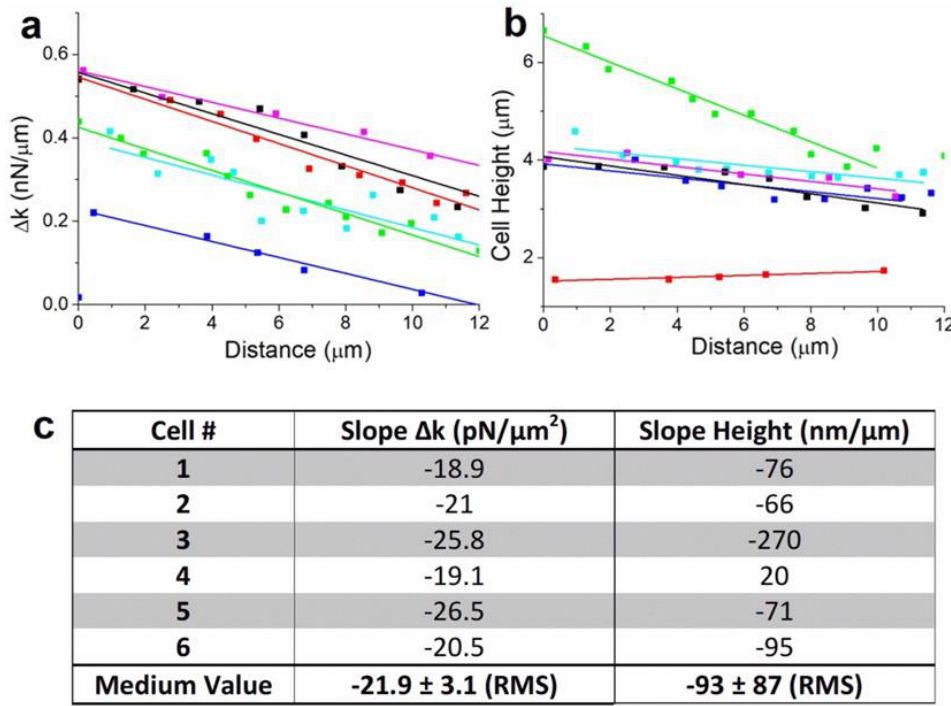
Figure 4. Analysis of the results for six different cells: Plot of ( a ) ∆ k rear-front and ( b ) cells height, as function of the traveled distance with linear fitting of the respective curves. ( c ) Calculated values of slope of ( ∆ k) and cells height for the six experiments.